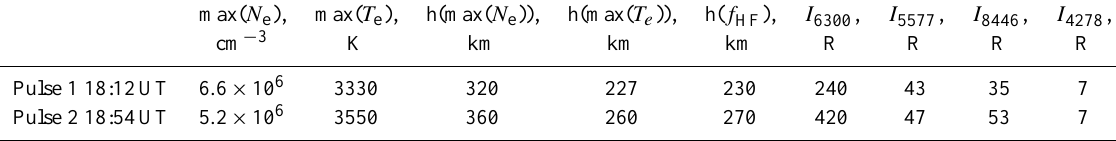
Table 2. Ionospheric parameters and optical emission intensities measured during the EISCAT heating experiment on 2 March 2002.